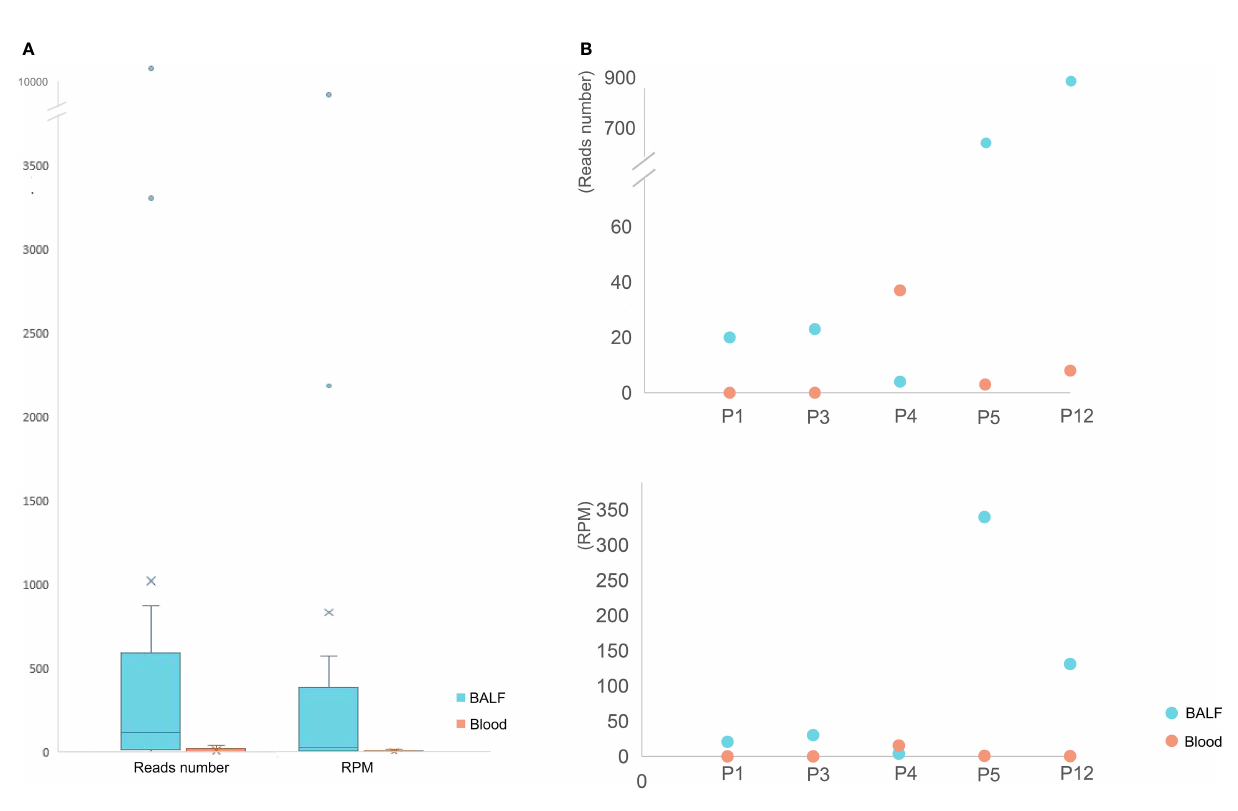
FIGURE 3 | The mNGS results of BALF and blood samples. (A) The read number and RPM of C. psittaci in BALF samples were signi fi cantly higher than those of blood samples. (B) The read number (top) and RPM (bottom) of C. psittaci of both BALF and blood samples in fi ve cases. P1 and P3 were negative by mNGS of